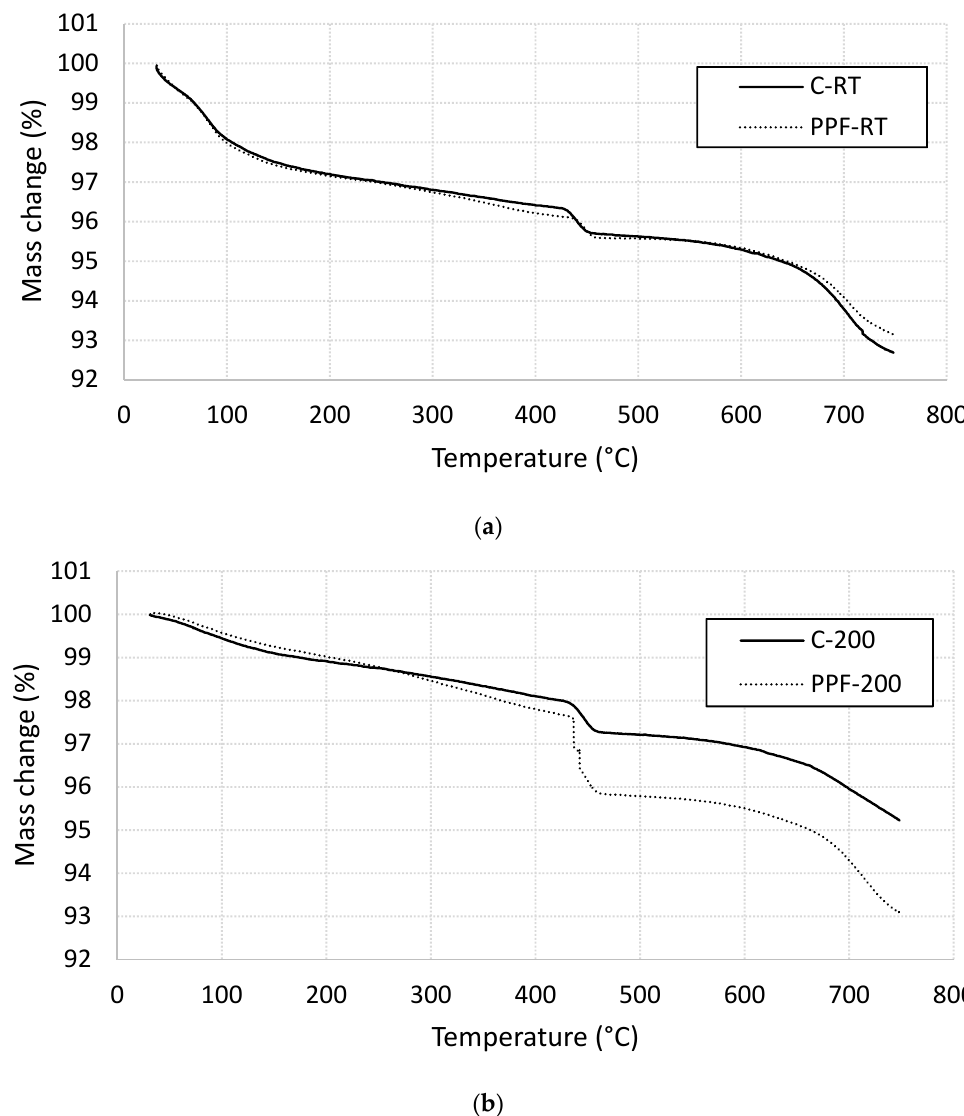
Figure 11. Thermogravimetric profiles for plain and fiber-reinforced specimens ( a ) at room temperatures ( b ) heated at 200 °C .